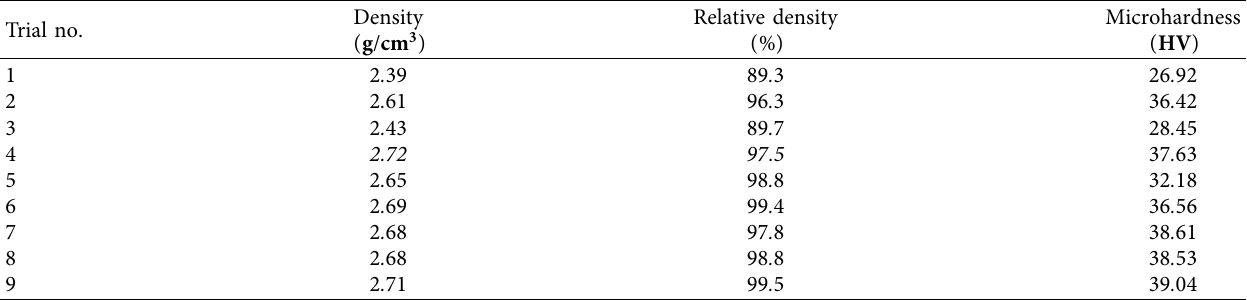
Table 3: Density and microhardness testing results.